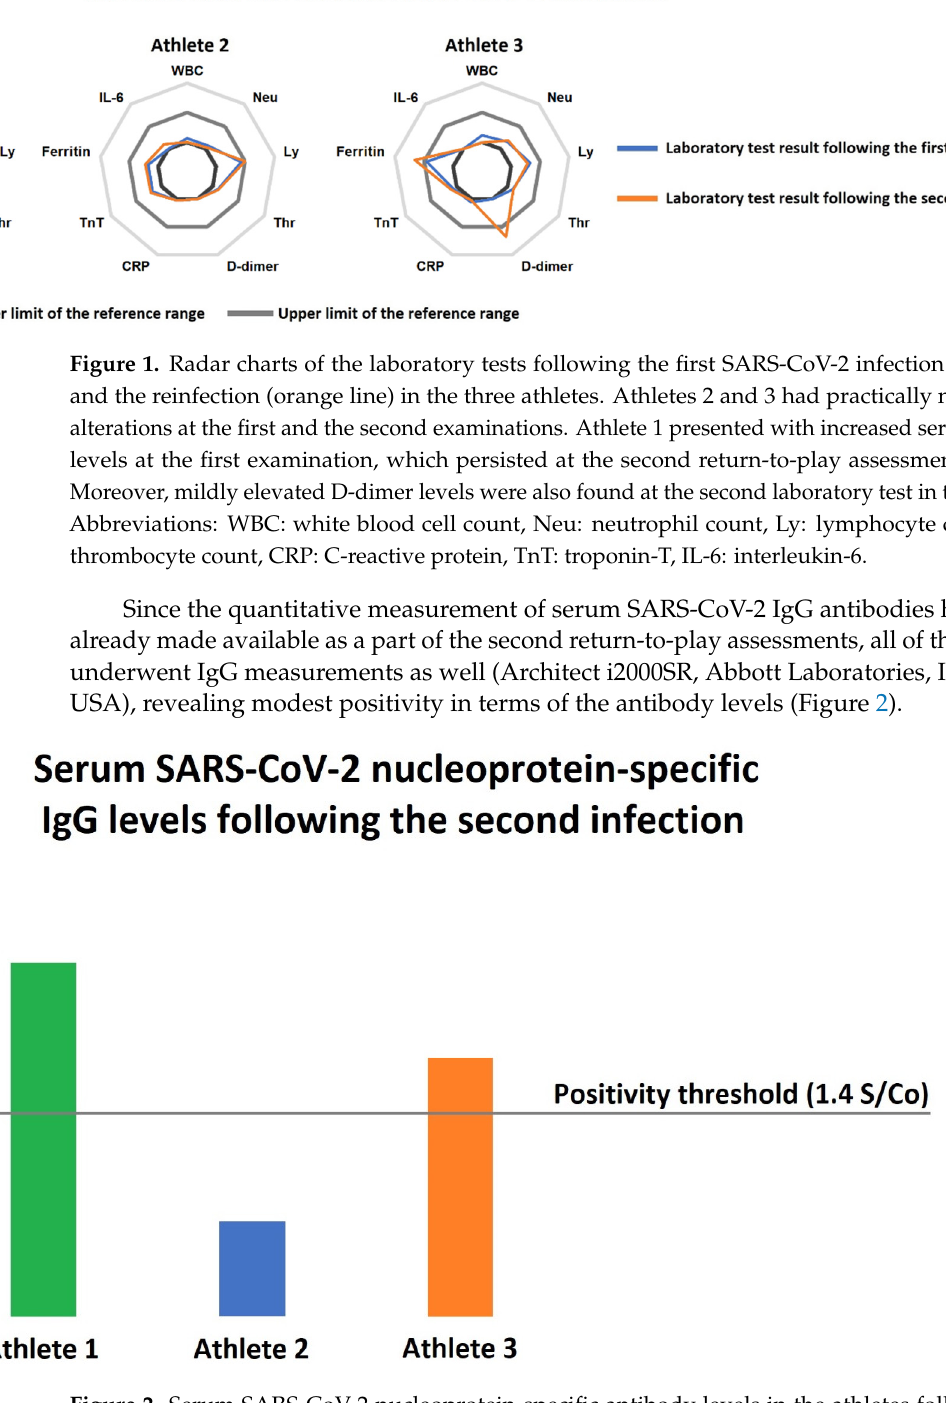
Figure 2. Serum SARS-CoV-2 nucleoprotein-specific antibody levels in the athletes following the reinfection. Humoral immunity was assessed following the second infection, showing only modest increases in the antibody levels. Interestingly, Athlete 2 had an antibody titer significantly below the positivity threshold even after the reinfection, while Athlete 3 also barely exceeded the accepted antibody-positivity level.